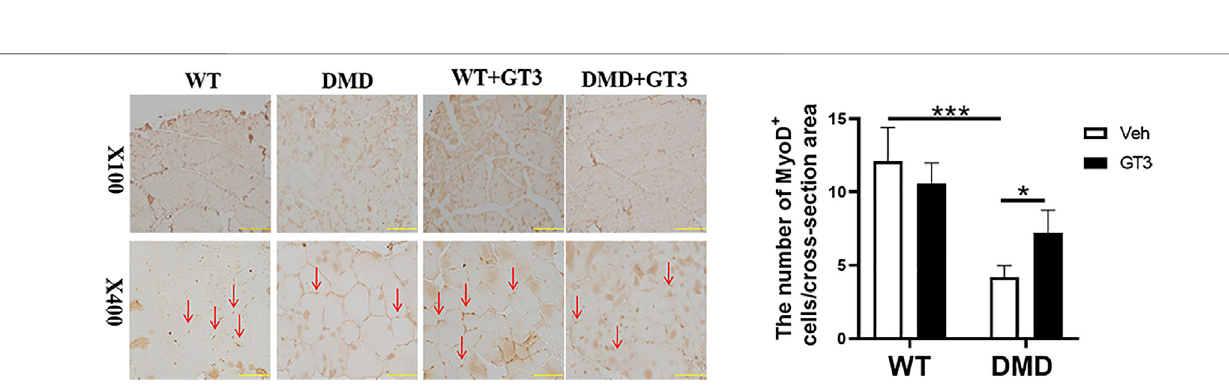
Frontiers in Cell and Developmental Biology |